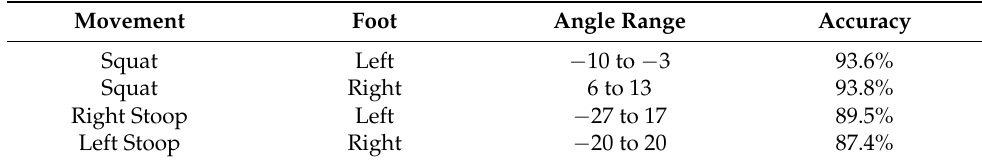
Table 2. Machine learning ankle angle prediction accuracy.